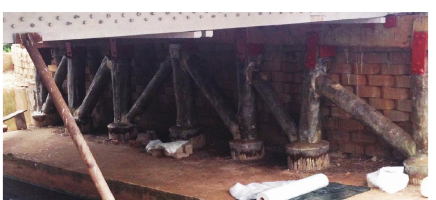
Figure5:TimberbridgethatusedgreencementasconcreteatKaase in Kumasi,